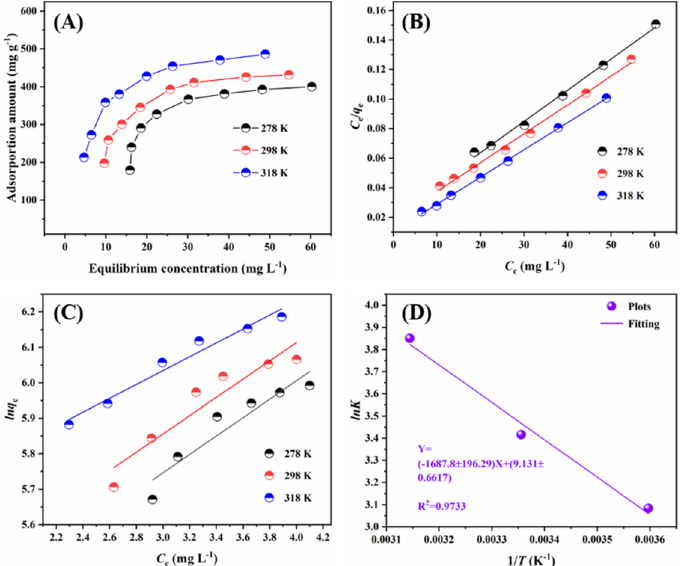
Figure 5. ( A ) adsorption isotherms at 278 K, 298 K and 318 K, ( B ) Langmuir isotherm model, ( C ) Freundlich isotherm model, and ( D ) Van Der Hoff equation. Experimental conditions: [Pb 2+ ] = 85–280 mg L − 1 , initial pH = 3.0, adsorbent dose = 0.01 g, solution volume = 25 mL; t = 12 h. Table 2. Adsorption isotherm parameters.